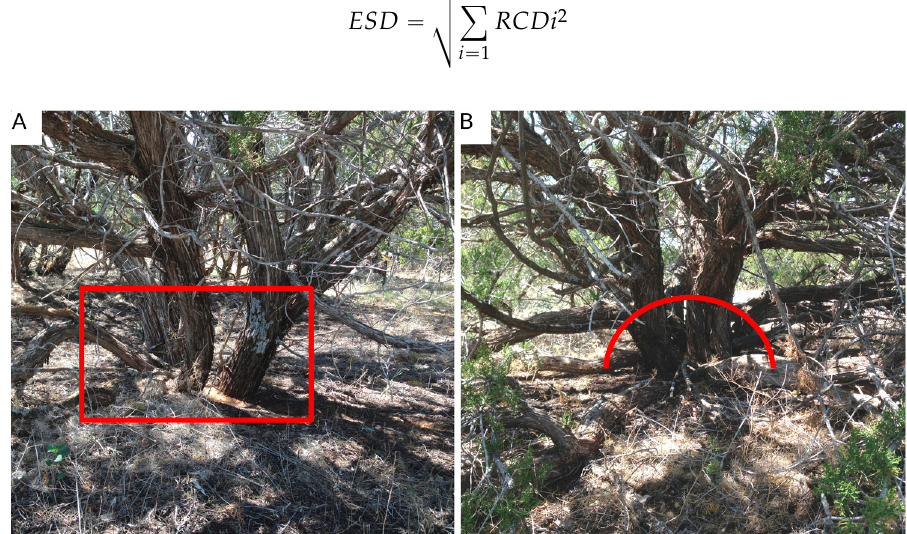
Figure 2. Typical branching patterns of Juniperus monosperma across the study area. Some individuals branch below the ground ( A ), while others branch above ( B ). Due to the woody mass that sometimes forms at the base of these trees, we measured equivalent stem diameters (ESD; Equation (1)) as illustrated in ( B ), using an ~30-cm radius from the woody mass to each stem diameter measurement.